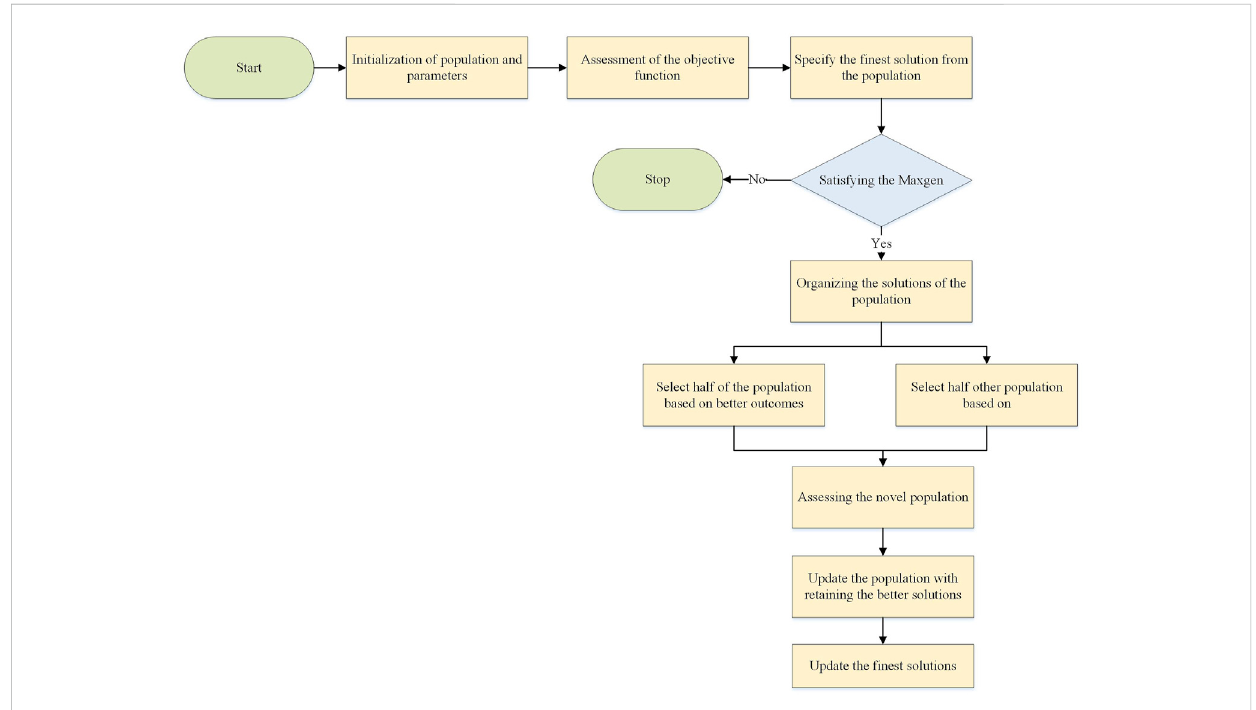
FIGURE 6 Flowchart of the BSO